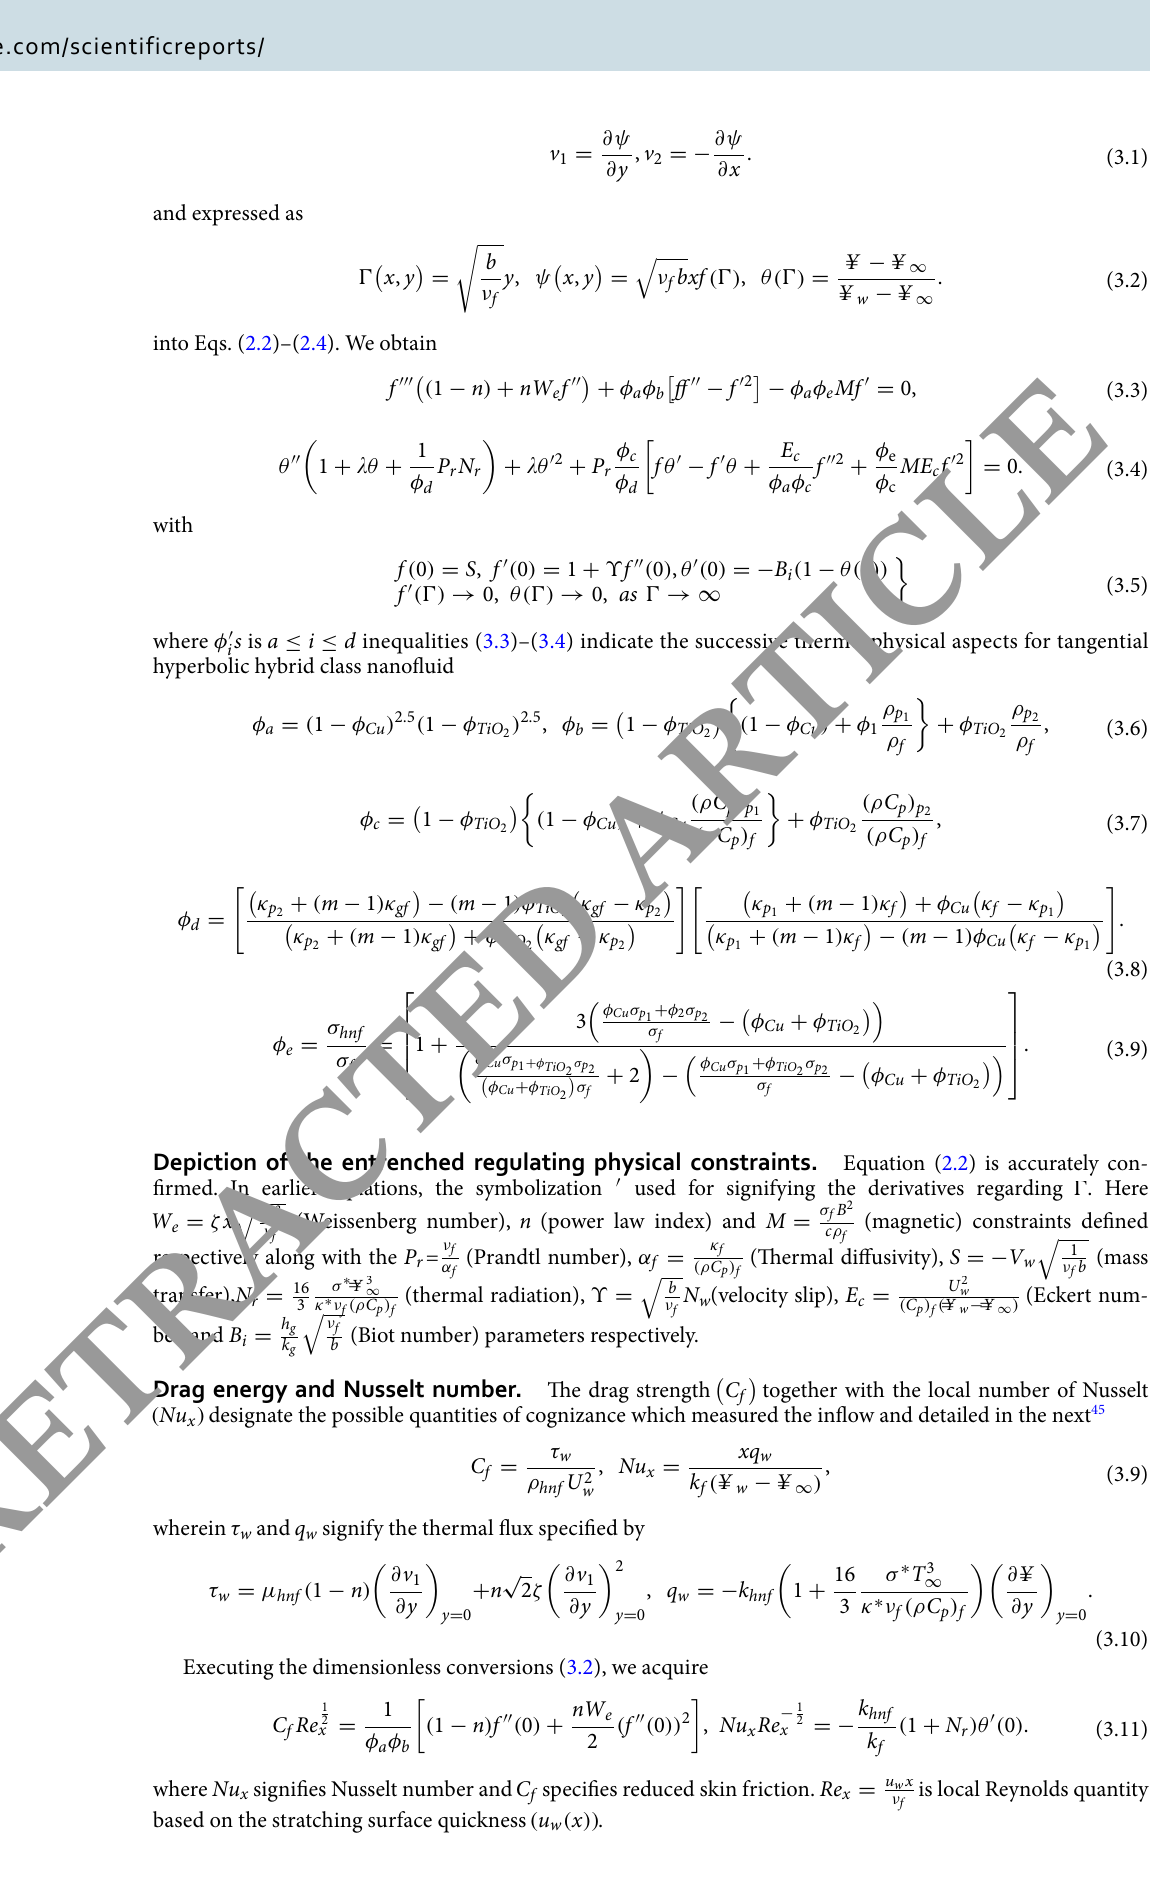
u w x ν f is local Reynolds quantity =